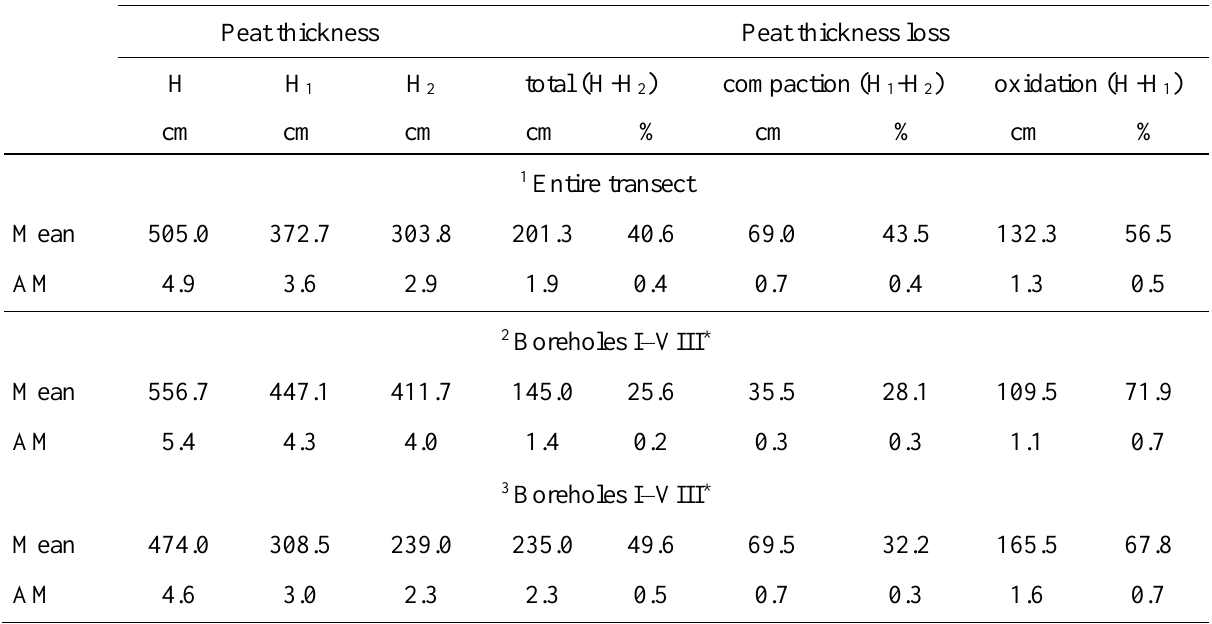
Table 3. The share of compaction and oxidation processes in subsidence of the peat grassland at Dublany in the years 1911–2015. Explanations: H = initial depth of the peat deposit (1882 or 1911); H = theoretical depth 1 of the current deposit (H ) if it were not compacted; H = current peat deposit depth (2015); (H - H ) = loss of 2 2 1 peat thickness due to oxidation; (H - H ) = loss of peat thickness due to compaction; * numbering of the 1 2 boreholes as in Figure 3; mean values of initial (w ) and current (w ) soil moisture content used for 1 2